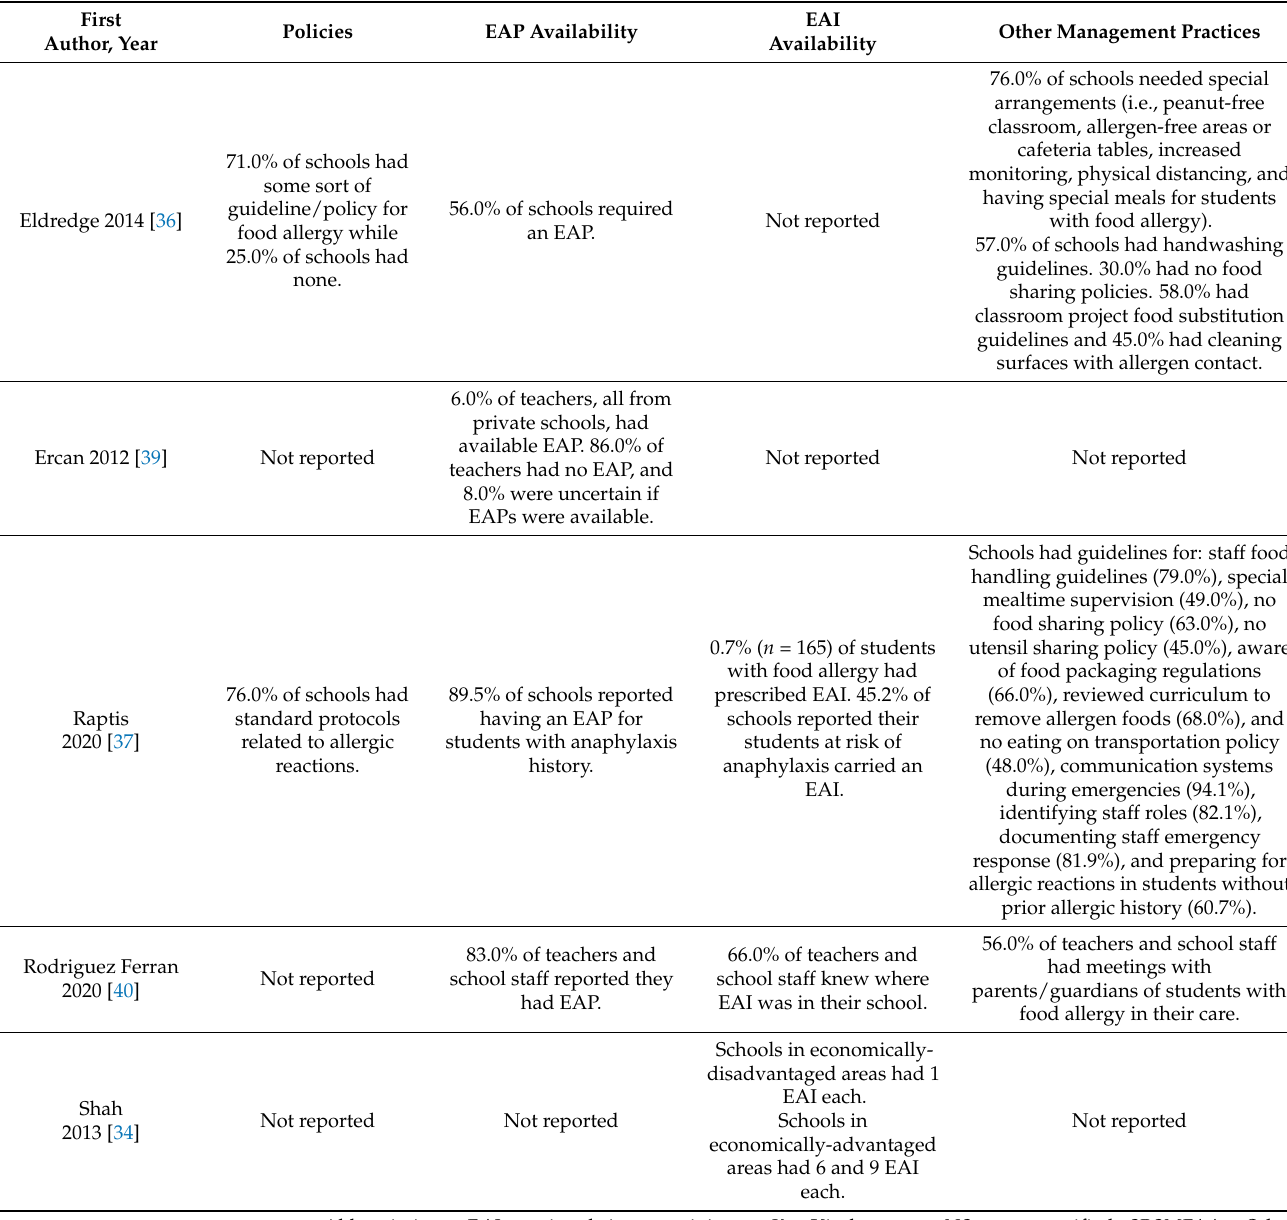
Table 2. Summary of in-school policies, emergency action plan, epinephrine auto-injector availability, and other management practices among schools, presented in alphabetical order by first author’s last